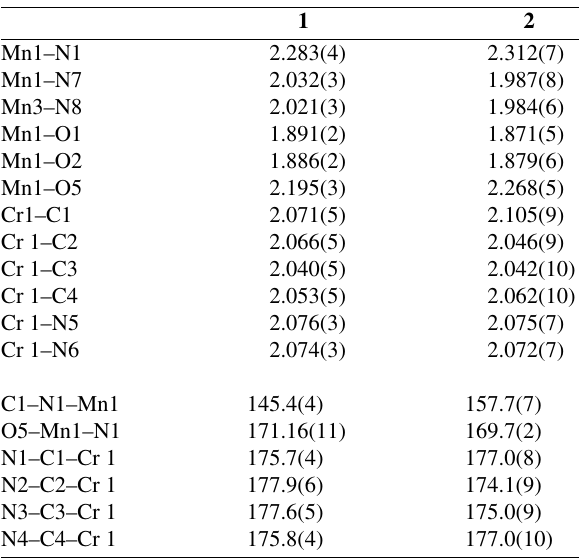
Table 2. Selected bond lengths (Å) and angles (°) for complexes 1 and 2 .